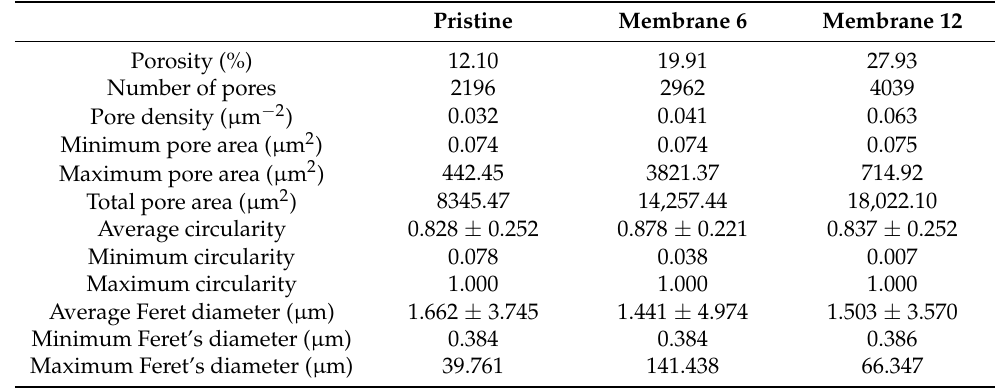
Table 3. Pore measurements for the support layer of the pristine membrane, as well as for the 6 and 12 weeks aged membranes prior to NF test based on the SEM cross-section × 300 magnification. Pristine Membrane 6 Membrane